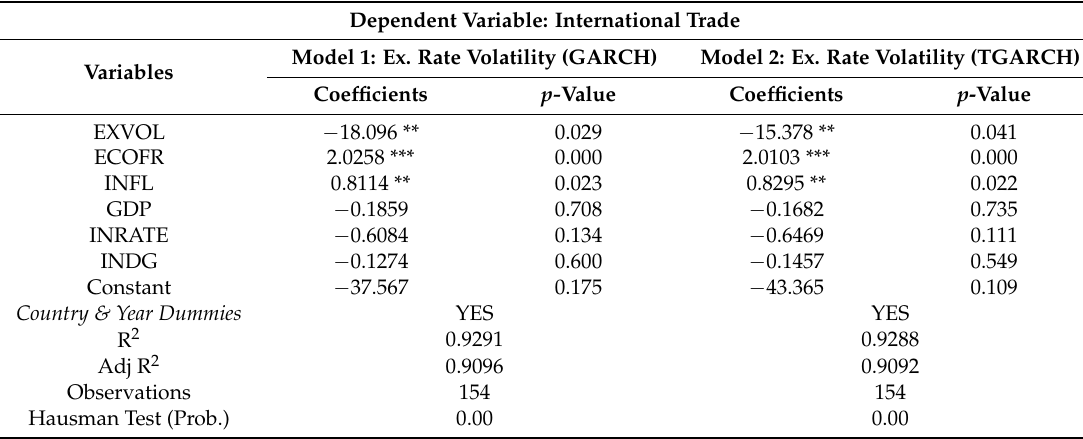
Table 5. International Trade and Exchange Rate Volatility: Aggregate (Panel) Level Estimation.